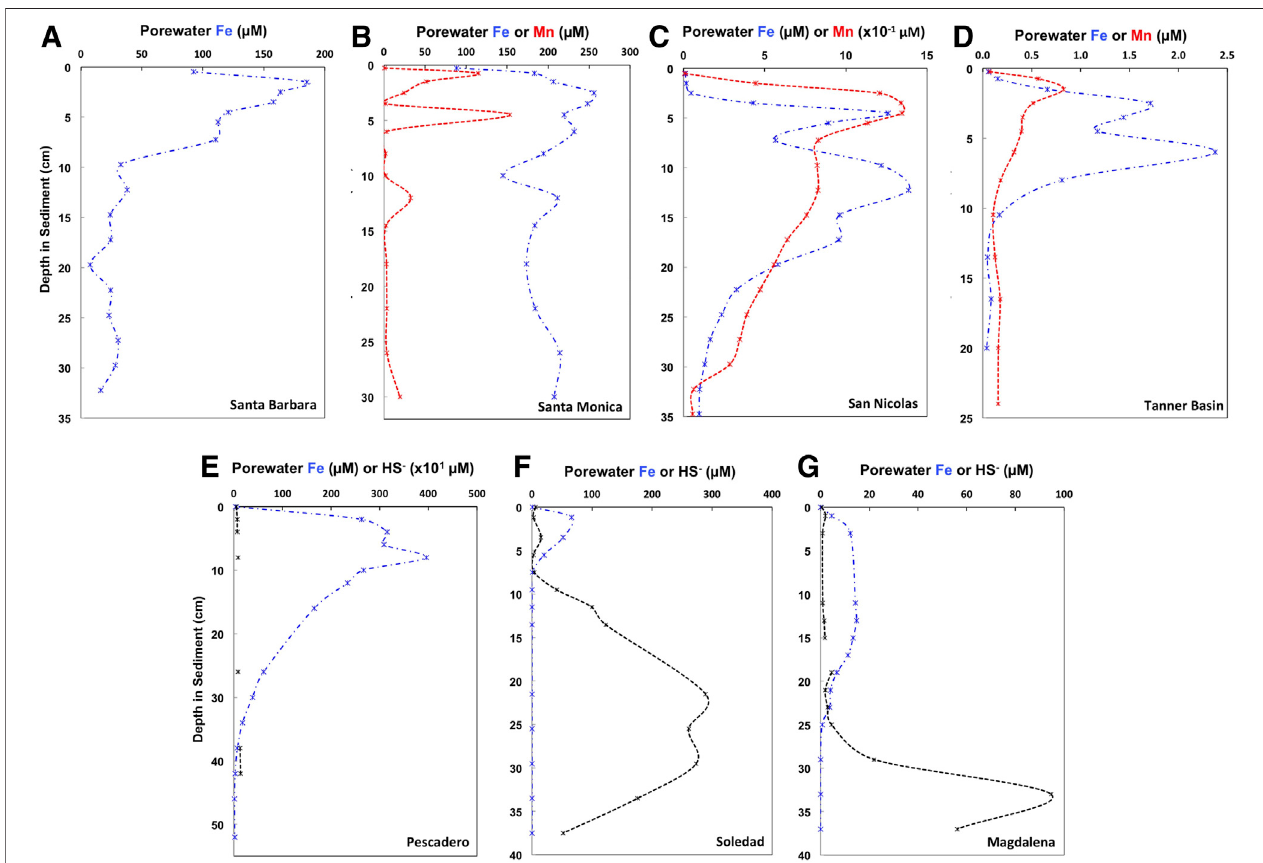
FIGURE 3 | Porewater Fe (blue dash-dot lines), Mn (red dashed lines) and HS - (black dashed lines) concentrations for seven sites from the two continental margin locations, the California Borderland Basins ( A – Santa Barbara, B – Santa Monica, C — San Nicolas, D — Tanner Basin) and the Mexican margin ( E — Soledad Basin, F — Pescadero slope, G – Magdalena margin). Values and references are shown in Supplementary Table 2 .